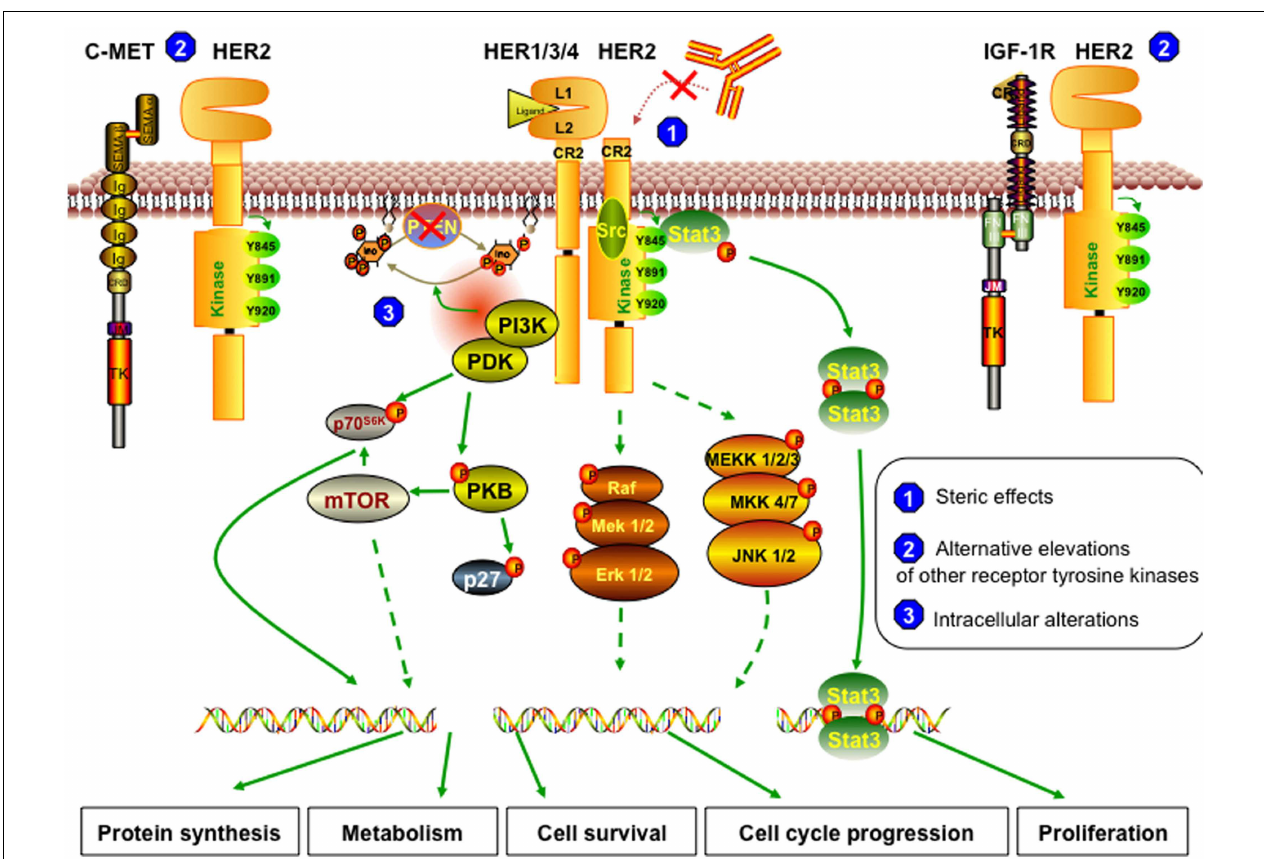
IGF-1R, the two most commonly reported, can trigger similar effects on cell behavior, even though HER2 signaling is inhibited by trastuzumab. (3) Intracellular alterations. In trastuzumab resistant cells, PTEN function is lost; thus, Akt is constitutively active. Also, resistant cells can harbor activating mutations in PI3K or Akt, which can trigger other downstream signaling pathways even when HER2 is blocked by trastuzumab or when PTEN is